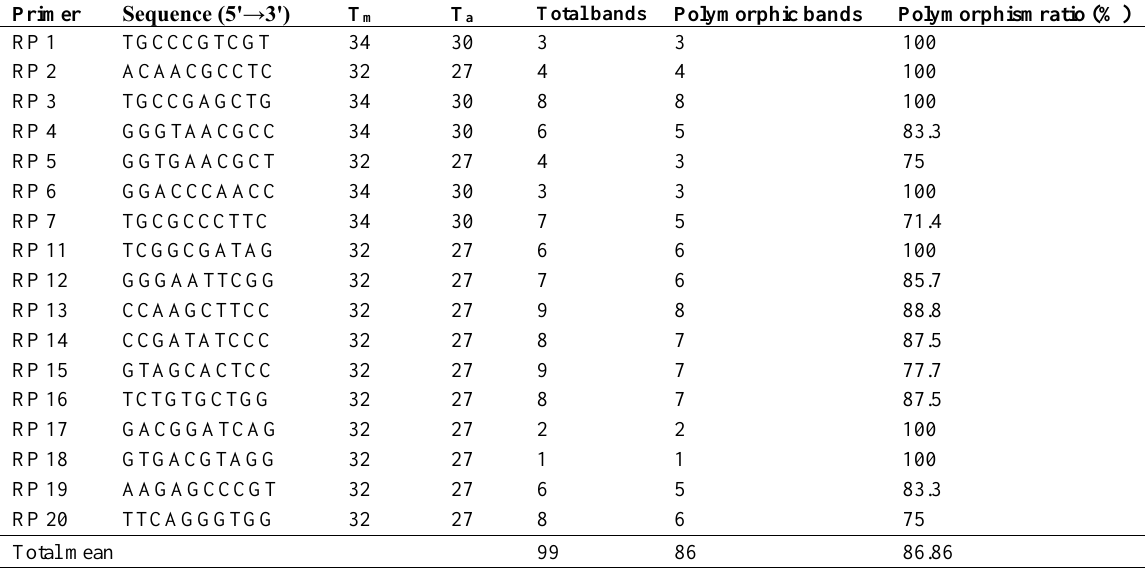
Table 3. List of RAPD primers along with their sequences, T m , T a , the number of polymorphic and total bands resultant from all tested wheat genotypes. Primer Sequence